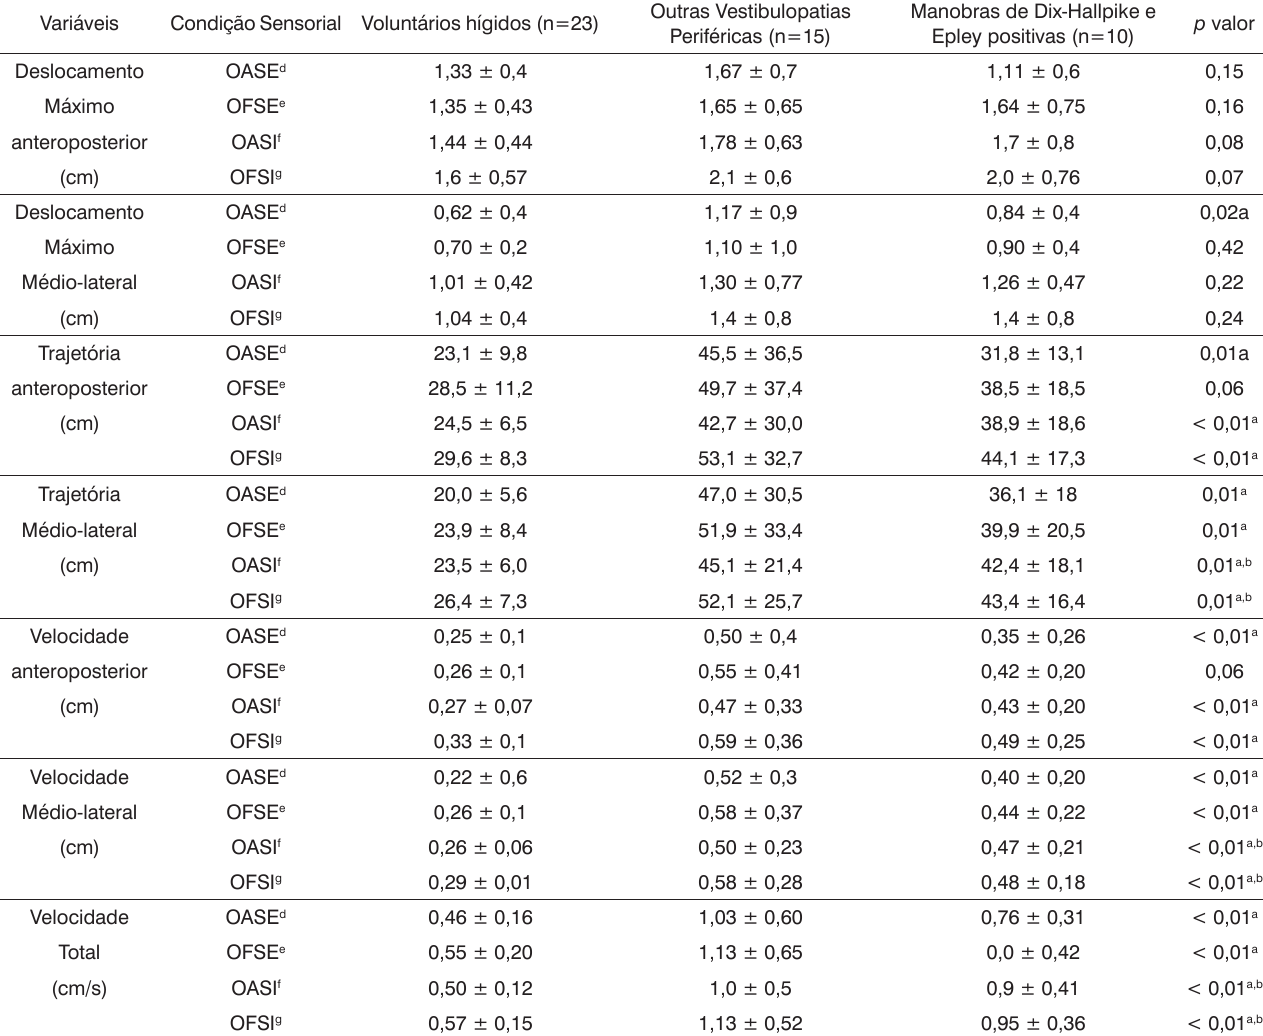
Tabela 2. Valores das variáveis estabilométricas dos três grupos em diferentes condições sensoriais.